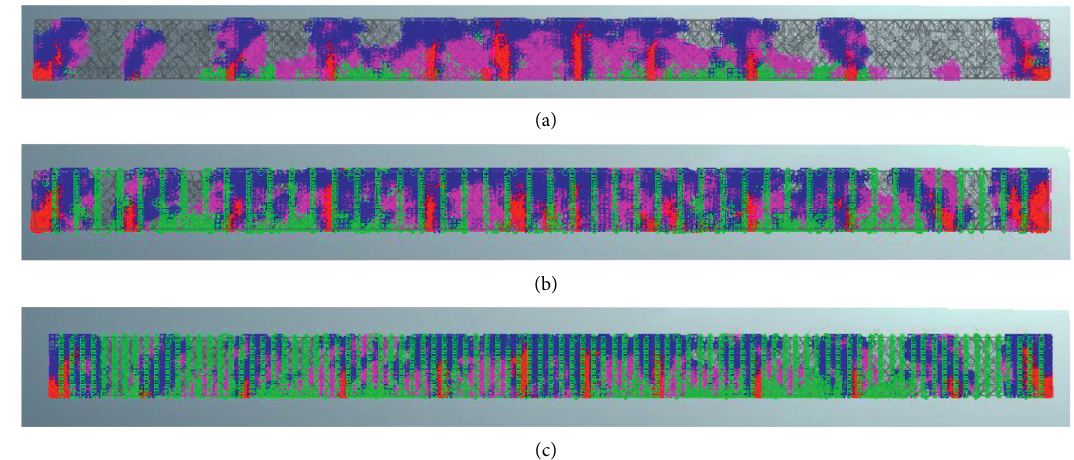
Figure 20: Crack pattern at ultimate limit state: (a) B-Control, (b) CFRP and (c)